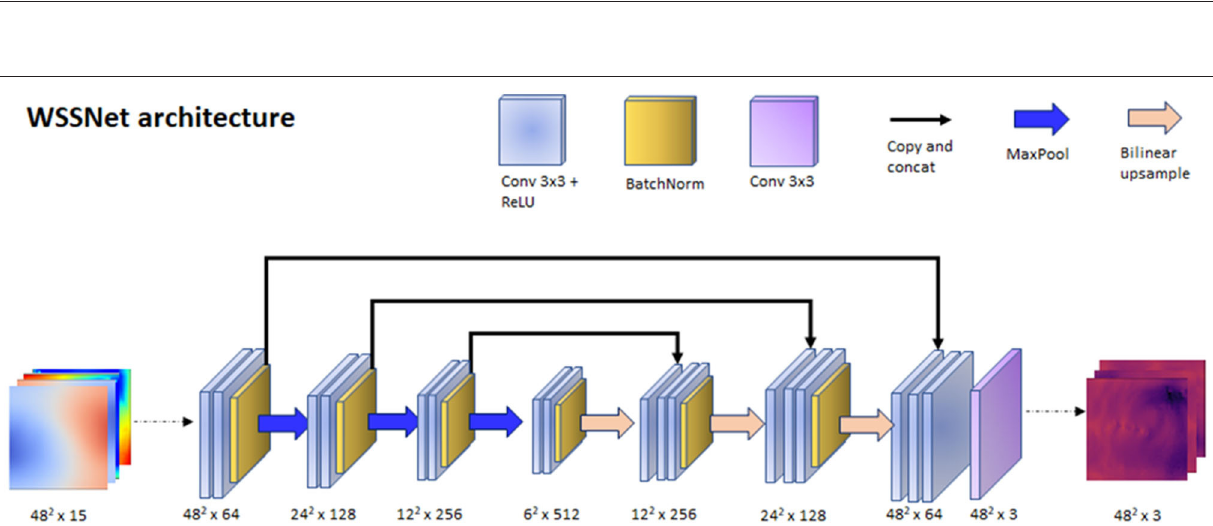
Frontiers in Cardiovascular Medicine |